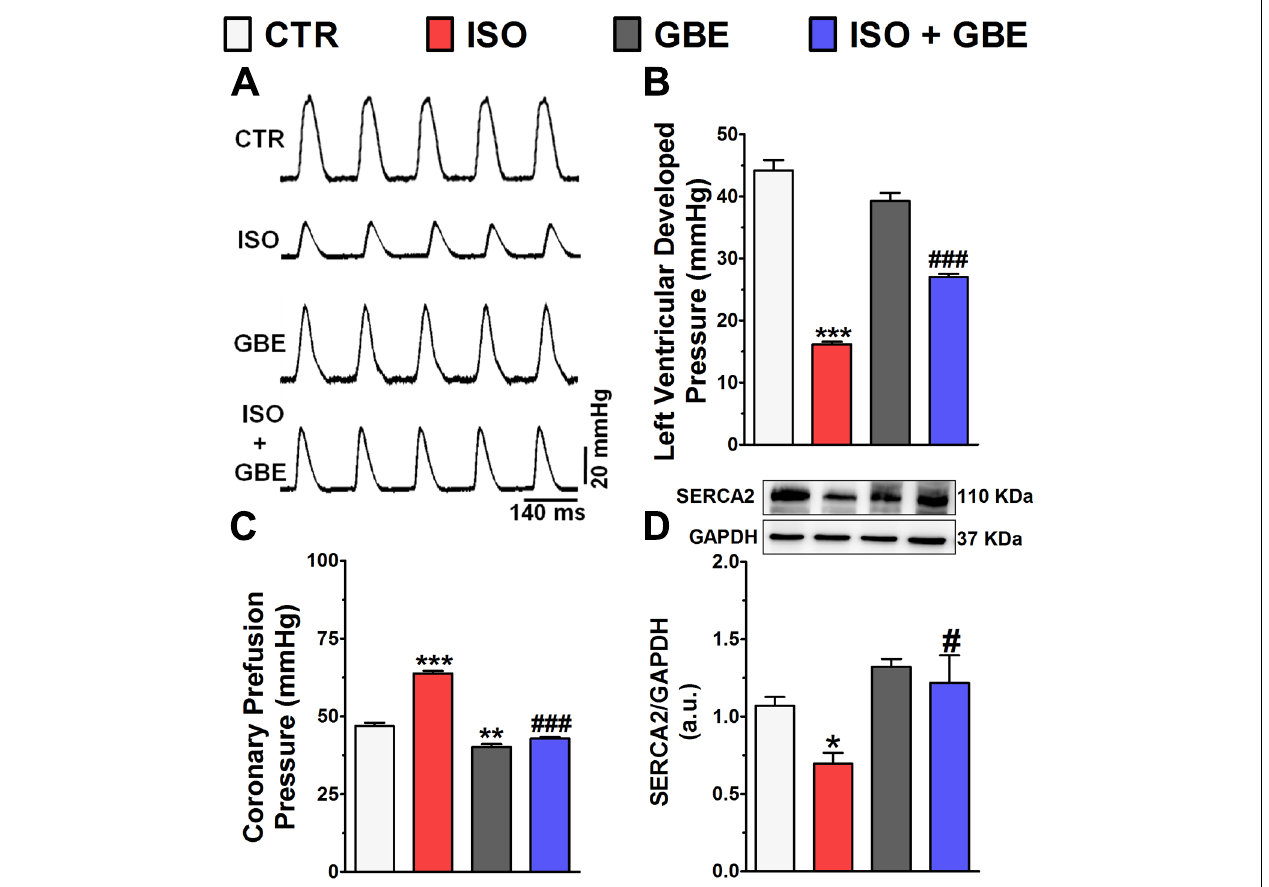
FIGURE 7 | Ginkgo biloba extract restores the impaired ventricular contractility induced by chronic β -adrenergic stimulation. (A) Representative left ventricular pressure recordings. Bar graph shows (B) left ventricular developed pressure measurements, (C) coronary perfusion pressure, (D) representative western blot and quantitative analysis of SERCA2. Data are represented as means ± SEM, ( n = 6). ∗ p < 0.05, ∗∗ p < 0.01, and ∗∗∗ p < 0.001 vs. CTR; # p < 0.05 and ### p < 0.001 vs. ISO, one-way ANOVA followed by Bonferroni’s